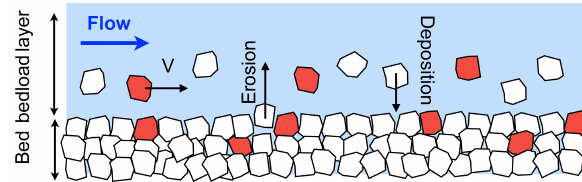
Figure 1. Granular bed sheared by a steady and uniform flow. The bed is a mixture of marked (red) and unmarked (white)